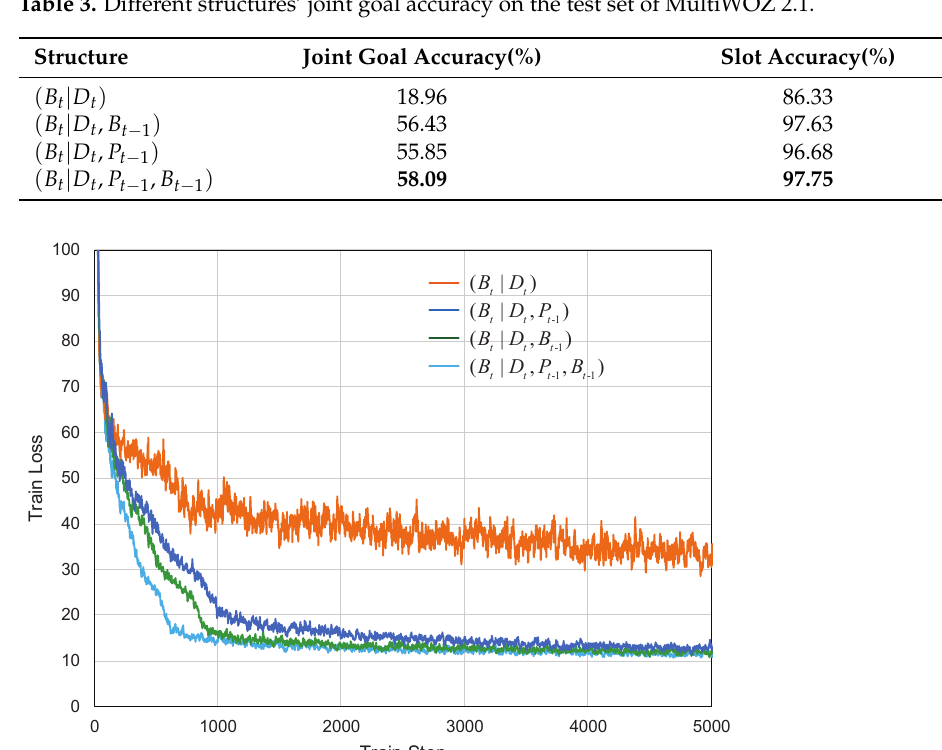
Table 3. Different structures’ joint goal accuracy on the test set of MultiWOZ 2.1.